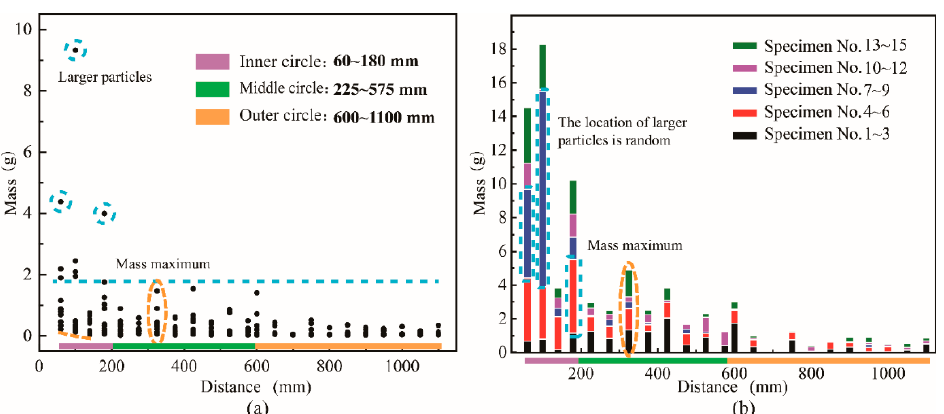
Figure 13. Spatial distribution characteristics of surface particles. ( a ) Scatter plot of particle spatial distribution ( b ) Summary of particle spatial distribution of each group